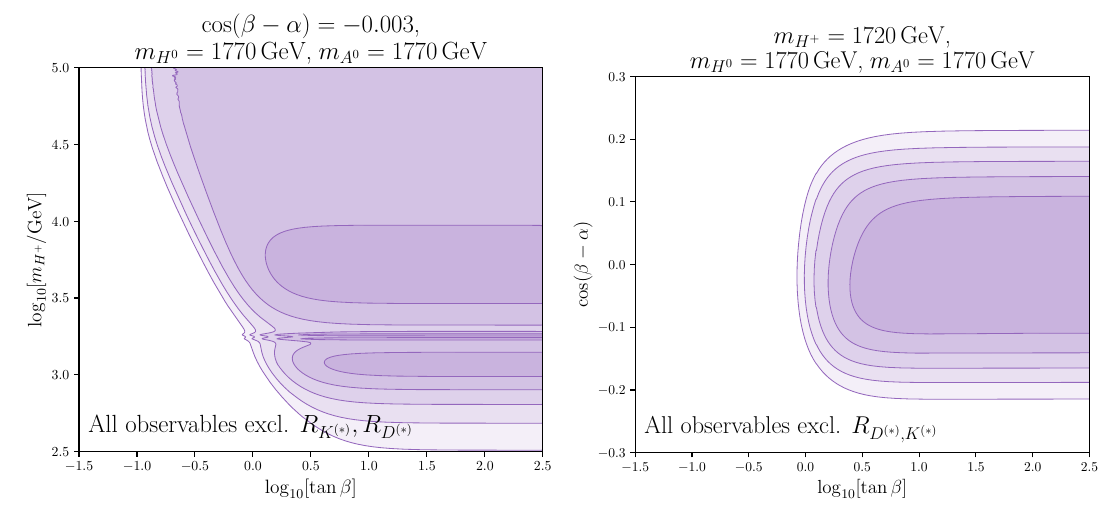
Figure 9 . Combined fit of all flavour observables (excluding R and EWPOs in the 2HDM-I (in the tan β − m best-fit points. Contours are shown representing allowed parameter space at 1,2,3,4,5 σ confidence from darkest to lightest.